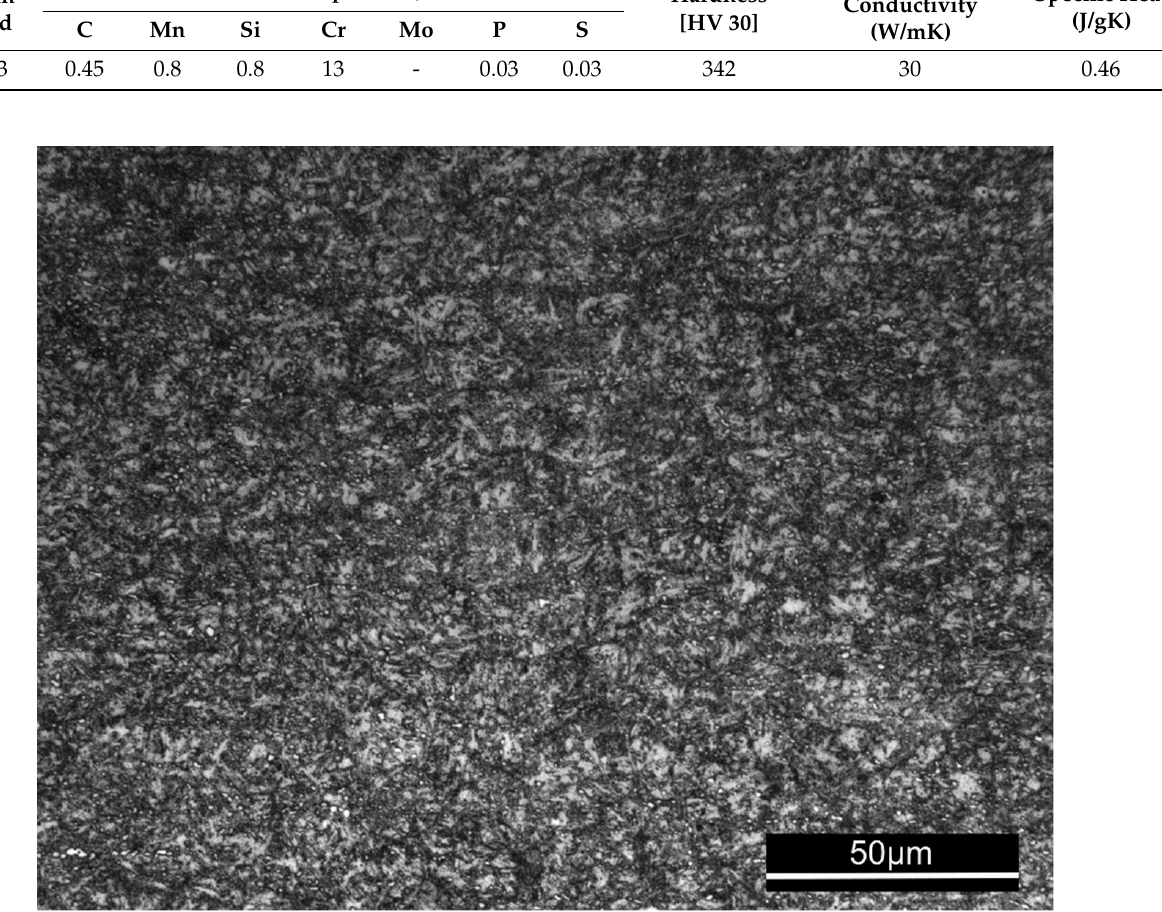
Figure 3. Microstructure of the conventional martensitic stainless steel obtained from an optical microscope. Microetchant: Kalling I (100 ml: 33 ml distilled water, 33 ml ethanol 96%, 33 ml HCl 32%, 1.5g Copper (II) chloride). Table 2. Composition and properties of the conventional martensitic stainless steel Chemical composition, wt.% European standard